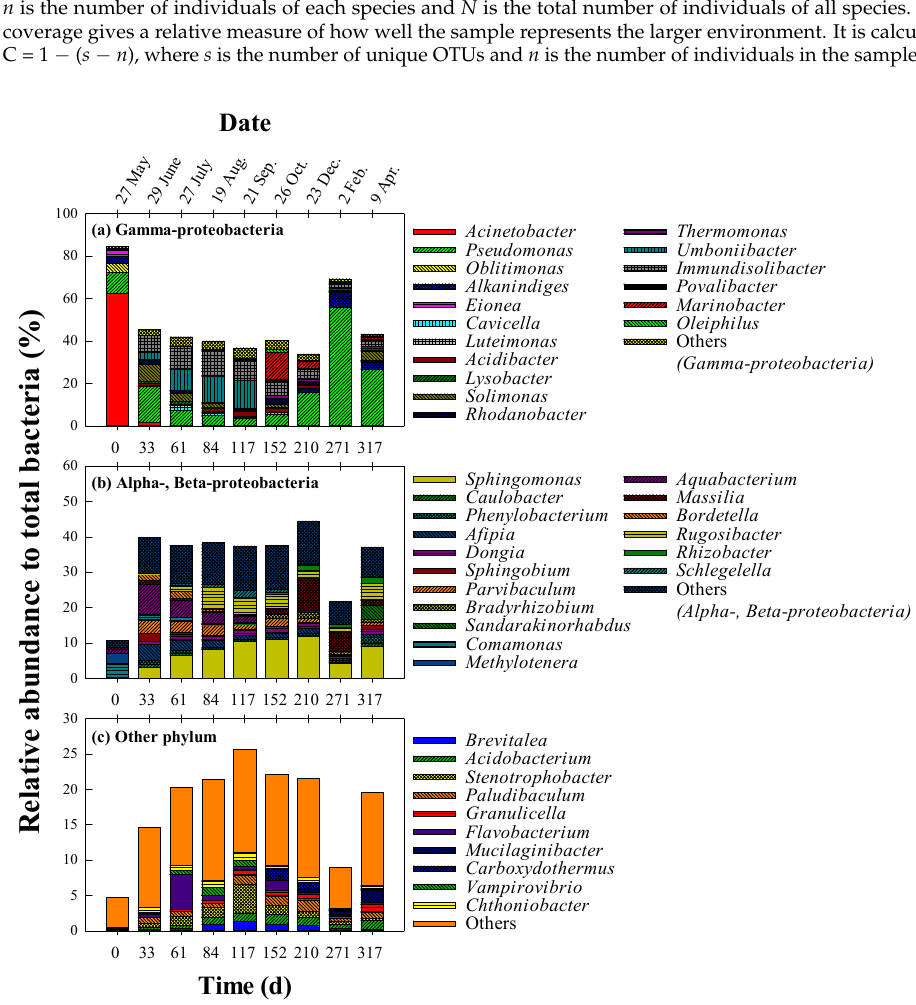
Figure 3. Changes in the bacterial community structure in the diesel ‐ contaminated soil. ( a ) Genera of Gamma ‐ proteobacteria, ( b ) Alpha ‐ and Beta ‐ proteobacteria, and ( c ) other phylum. Only genera with a relative abundance of >1% are illustrated.